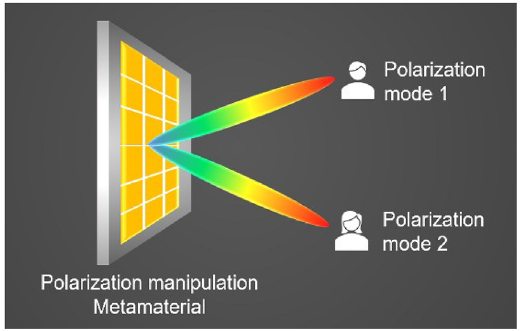
Figure 21: Polarization manipulation